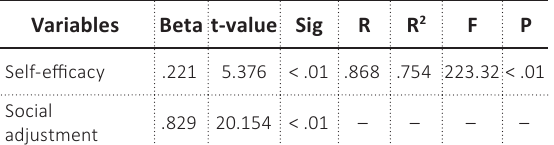
Table 2. Summary of multiple regression showing the joint and independent influence of self- efficacy and social adjustment on achievement